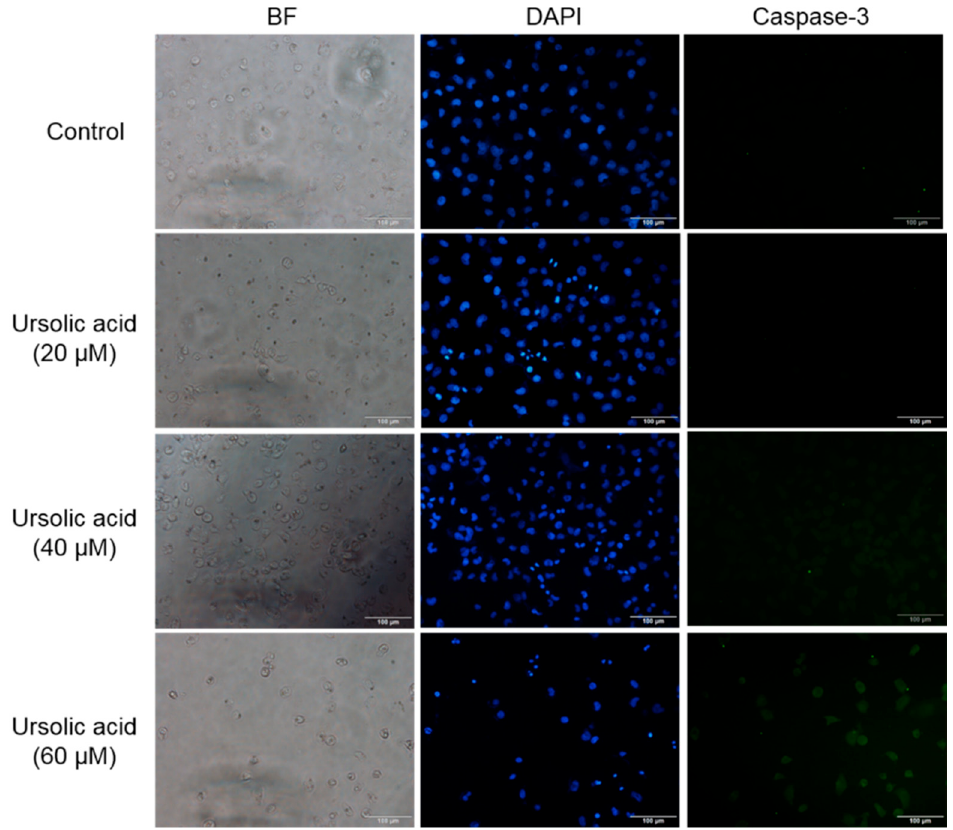
Figure 6. UA increased the expression of caspase-3 in Huh-7 cells. After cells were treated with various doses of UA for 24 h. The expression of caspase-3 was analyzed by immunocytochemical